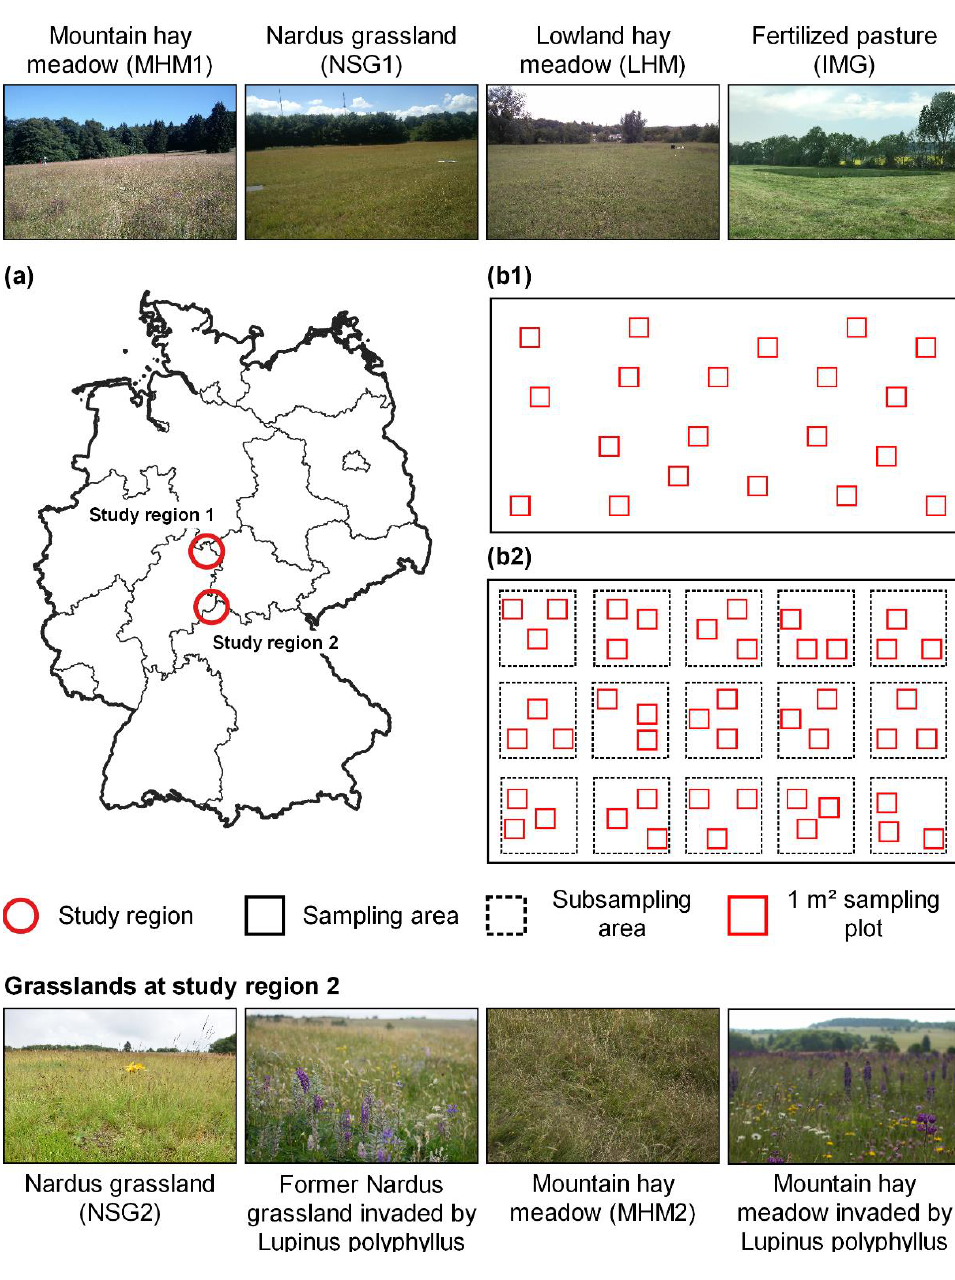
Figure 1. ( a ) Location of study regions 1 and 2 in Germany. ( b1 ) Sampling design for biomass sampling at study region 1. ( b2 ) Sampling design for biomass sampling at study region 2. The photos depict the grassland composition at all grassland sites at study region 1 ( top ) and 2 ( bottom ).